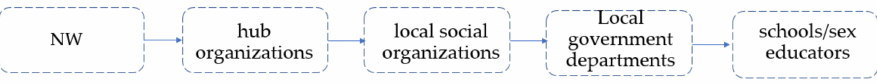
Figure 1. The top-down program